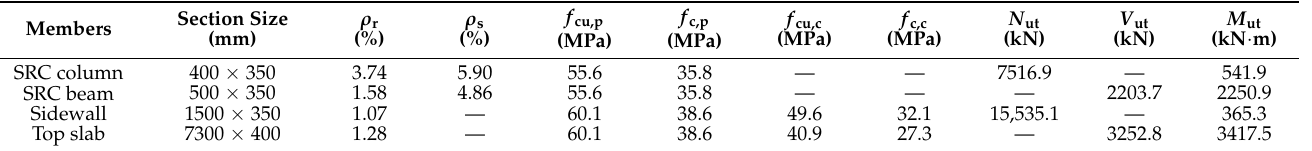
Table 1. Parameters of the test